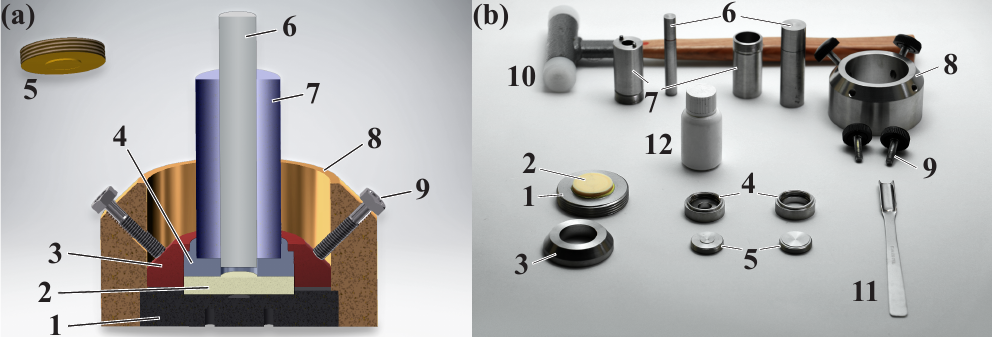
Figure 1. ( a ) Cross section through the assembled powder press. 1: bottom plate, 2: ceramic slice, 3: bouncing plate, 4: sample ring, 5: cover plate, 6: tappet, 7: funnel, 8: cylinder, 9: screw. ( b ) Photograph of the powder press components. 1: bottom plate, 2: ceramic slice, 3: bouncing plate, 4: sample ring (left: 10mm hole diameter, right: 20mm hole diameter), 5: cover plate (left: 10mm diameter, right: 20mm diameter), 6: tappet (left: 10mm diameter, right: 20mm diameter), 7: funnel (left: 10mm hole diameter, right: 20mm hole diameter), 8: cylinder, 9: screws, 10: recoil-free hammer, 11: spatula, 12: powder